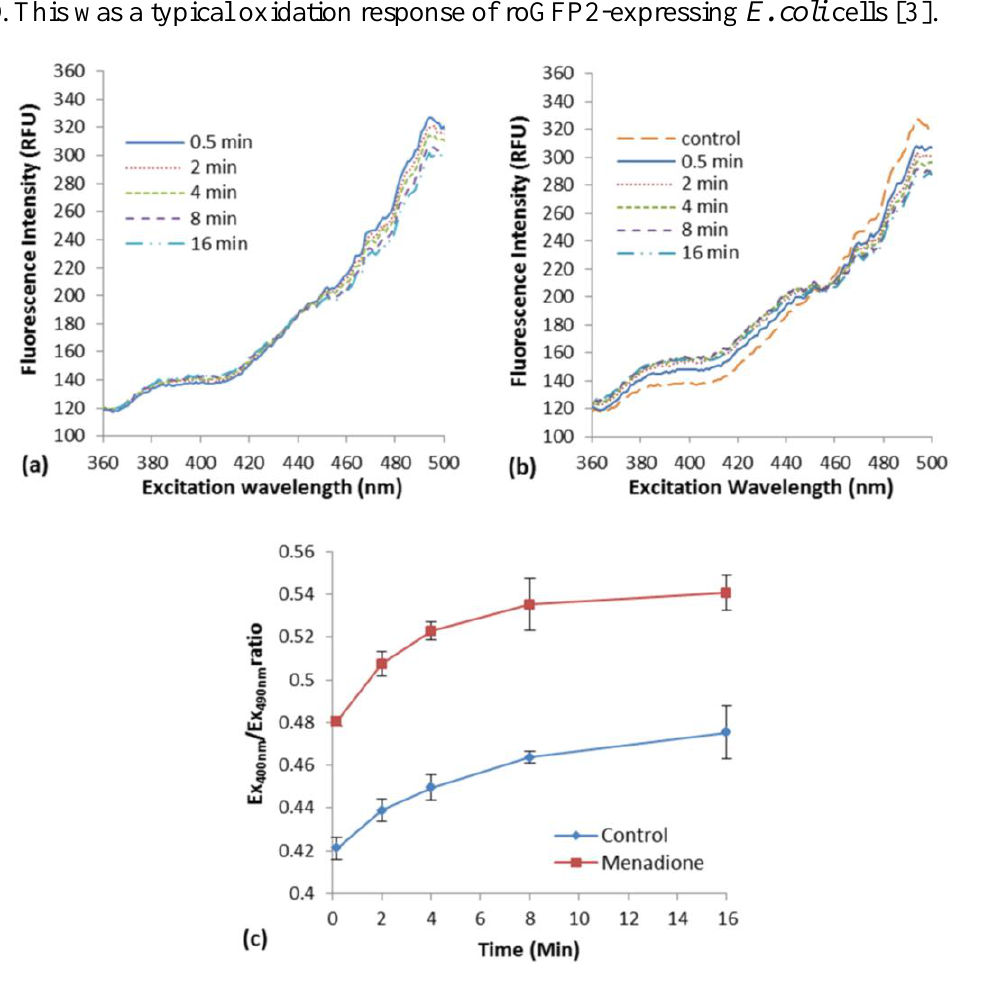
Figure 1. ( a ) Excitation spectra of E. coli roGFP2 cells in buffer suspension without menadione; ( b ) Excitation spectra of E. coli roGFP2 cells in buffer suspension after exposure to menadione. Spectra are representative ones for each treatment. “Control” in (b) represents 0.5 min excitation spectra of E. coli roGFP2 in buffer suspension. RFU, relative fluorescence unit; ( c ) Changes in fluorescence ratio of E. coli roGFP2 cells in HEPES buffer suspension, pH 7.0 in the presence of 1 mg·L −1 menadione ( n = 3). Error bars indicate standard